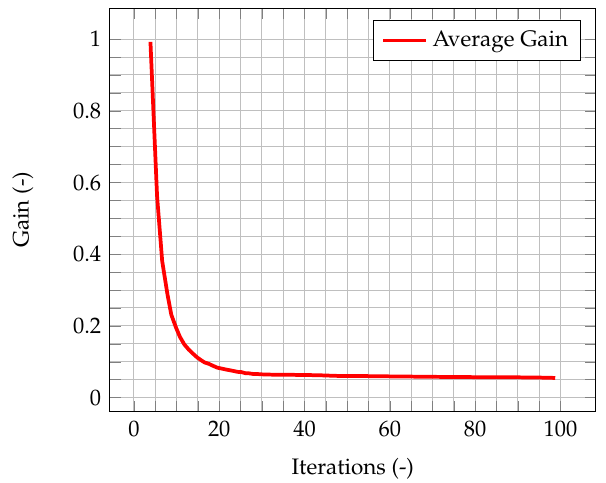
Figure 5. Time evolution of the average Kalman gain for velocity within the domain, highlighting its exponential-like behavior and its stationary value once convergence is reached.